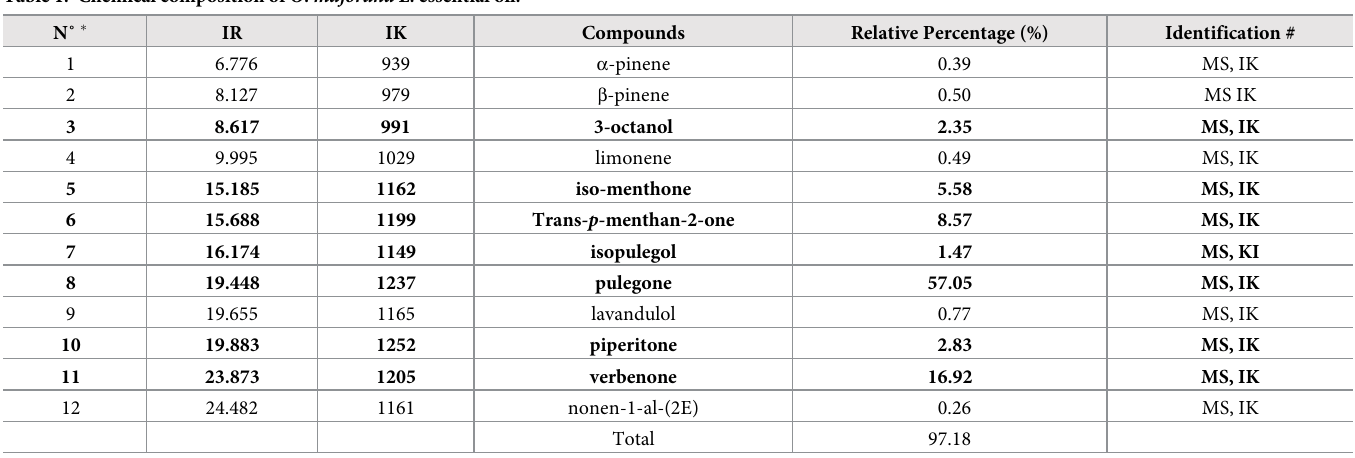
Table 1. Chemical composition of O . majorana L. essential oil.